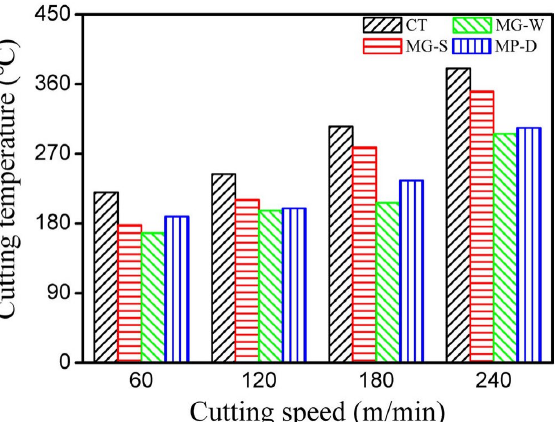
Figure 26. Cutting temperatures at the tool–chip contact interface of different tools at different cut- ting speeds ( a p = 0.2 mm, f = 0.102 mm/r) [75]